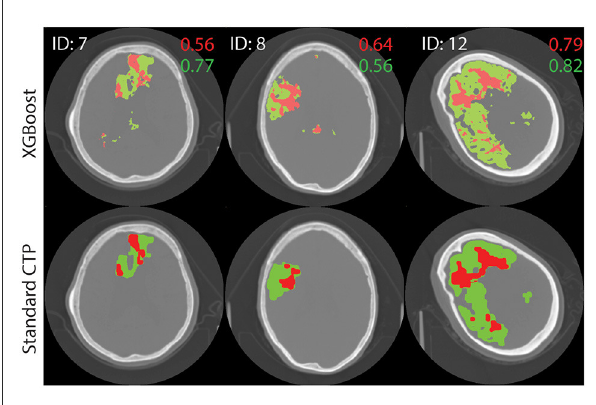
FIGURE4 Test image results. A single axial slice, selected to clearly display the lesion, is shown from each image. The results of processing test images through the XGBoost model to make a prediction on the class label is shown at top. Standard lesion maps are shown at bottom. The predictions for core (red) and penumbra (green) are shown on top of a single axial slice of the brain, obtain with non-contrast CT. Dice similarity score are shown on the image, in corresponding